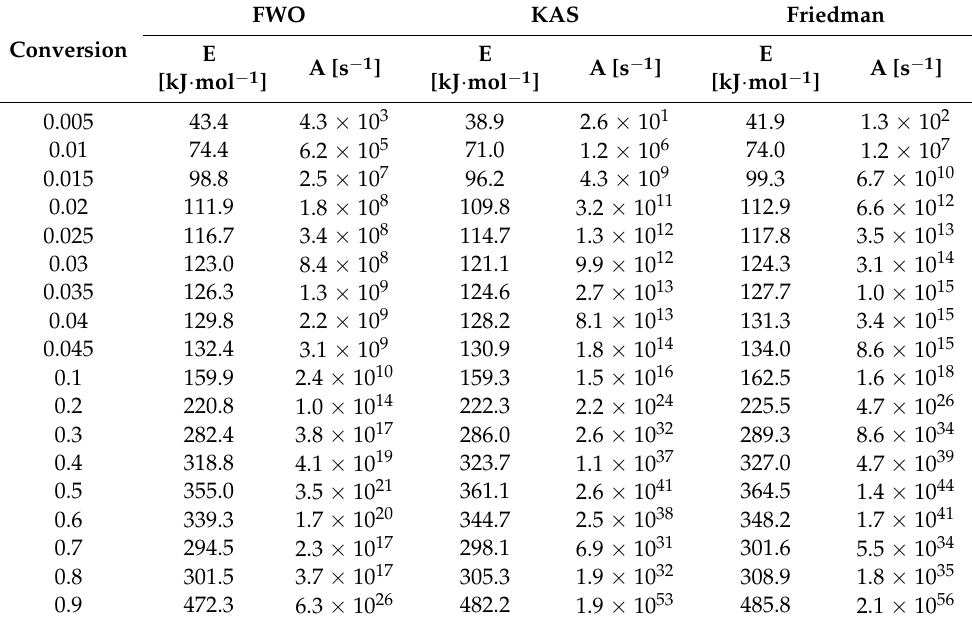
Table 13. Kinetic parameters of DNTT at heating rates less than 3 min − 1